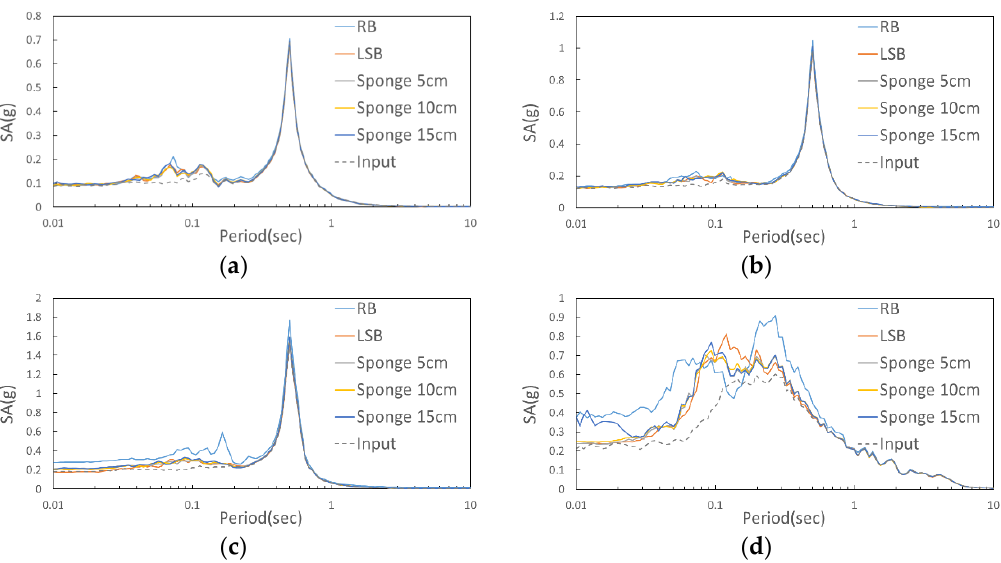
Figure 10. Surface acceleration spectrum by input motion: ( a ) Sine wave 2 Hz, 0.07 g; ( b ) Sine wave 2 Hz, 0.1 g; ( c ) Sine wave 2 Hz, 0.154 g; ( d ) Artificial seismic wave.